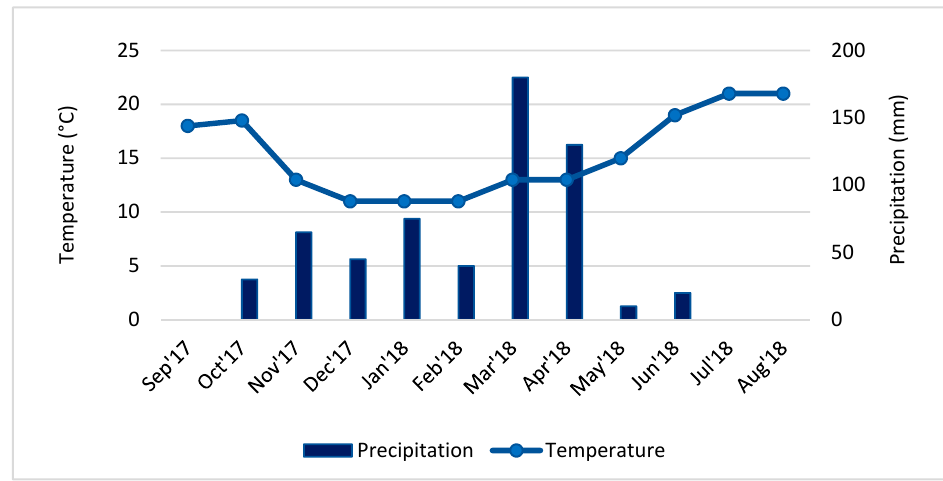
Figure 1. Average values of temperature and precipitation in the west center of Portugal between September 2017 and August 2018 [37].